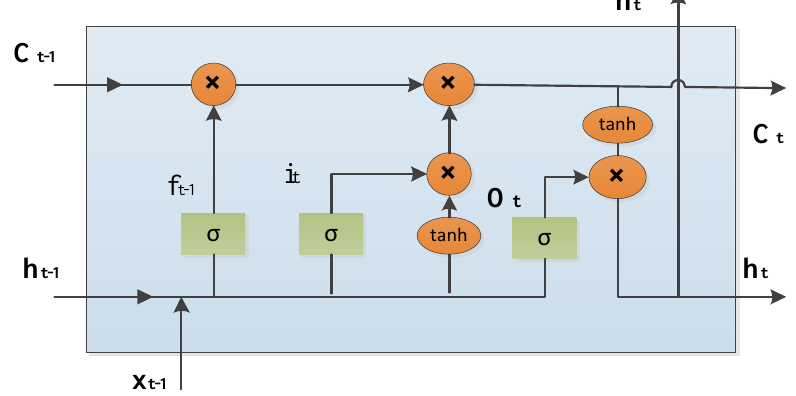
Figure 3. Structure of the LSTM network.